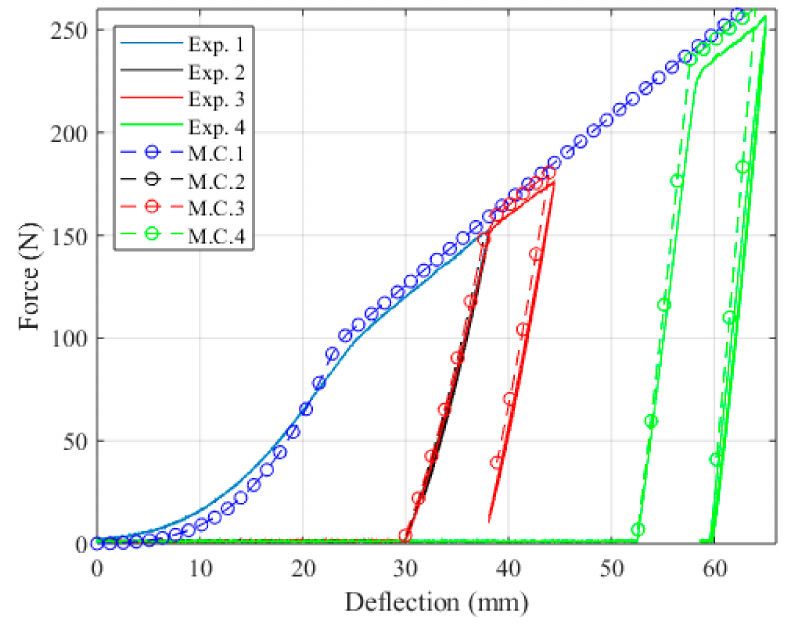
Figure 8. Static experimental results. Exp.—experiment.